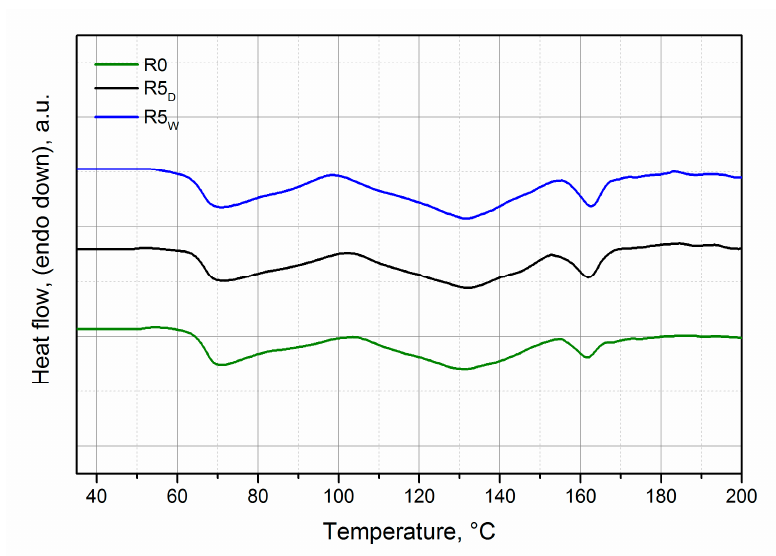
Figure 8. Thermograms of the virgin sample and of the samples reprocessed 5 times in dry and wet conditions. Table 3. Melting temperature and enthalpy of fusion of the virgin sample and of the samples reprocessed 5 times in dry and wet conditions.